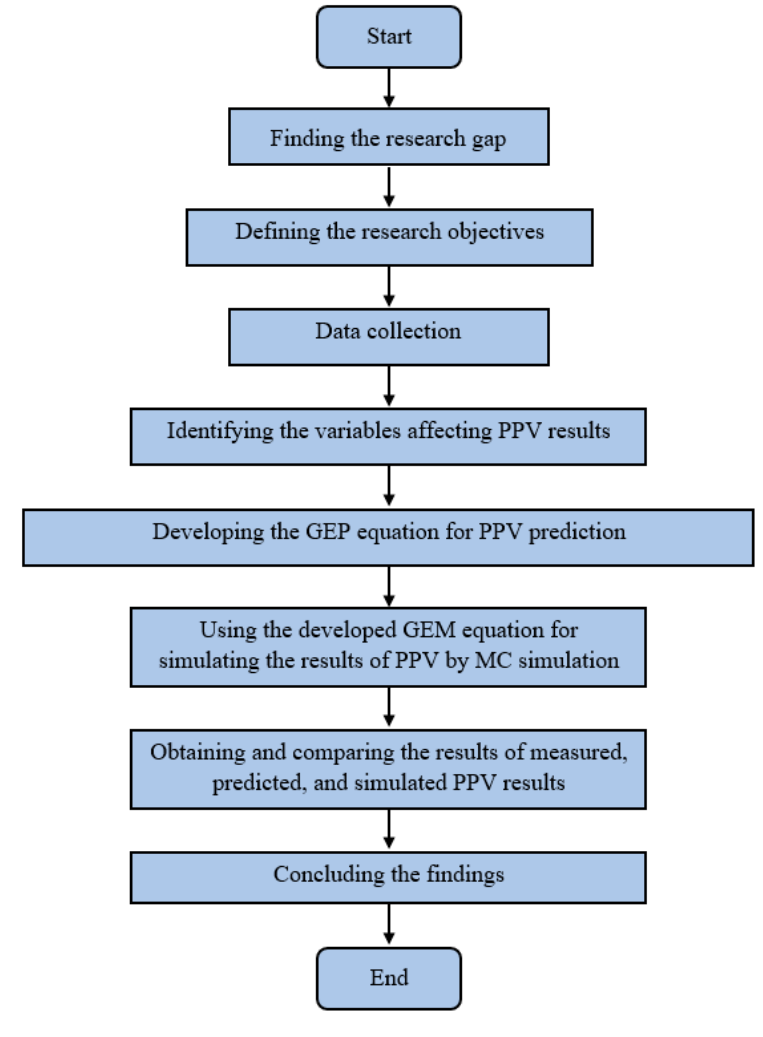
ff erent steps in this Figure 1. Flowchart of different steps in this study. Figure 1. Flowchart of di